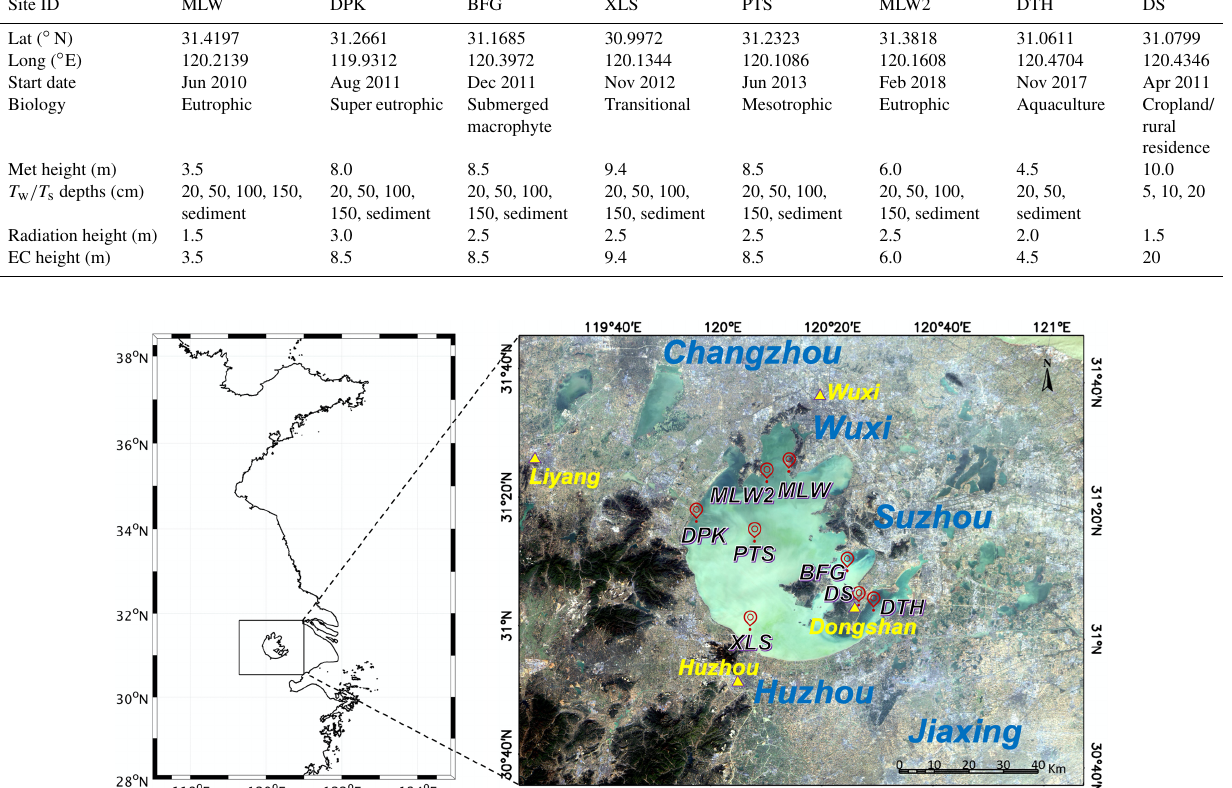
Figure 1. Map showing locations of Lake Taihu, eddy covariance sites (red bubbles) and WMO weather stations (yellow triangles). City names are shown in blue. DS is a land site, and MLW, MLW2, DPK, PTS, XLS, BFG and DTH are lake sites. The background is a natural color image from Landsat 8 without correction for atmospheric